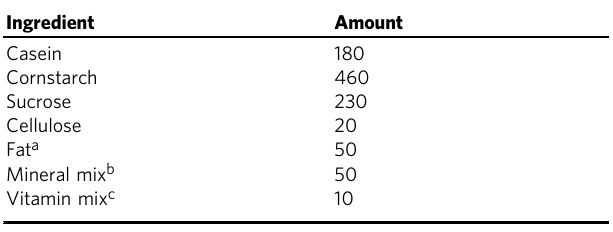
Table 1 Composition of the diets (g/kg